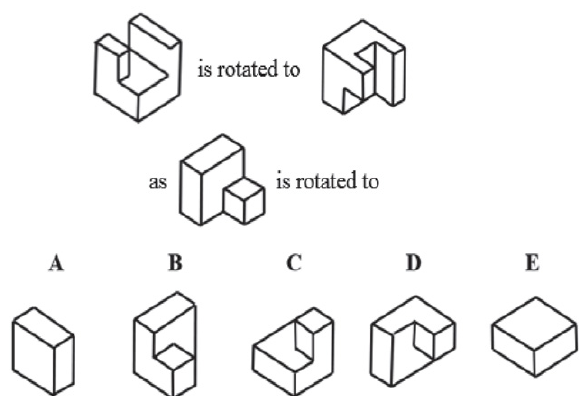
Figure 3. Example of a question in the